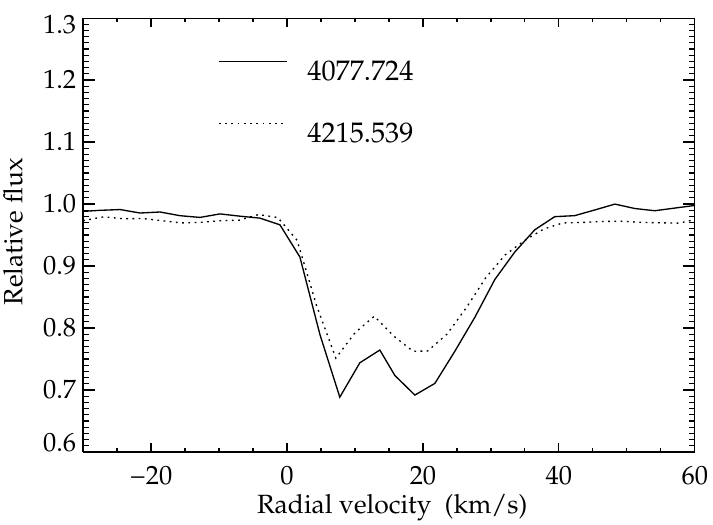
Fig. 5. Splitting of lines originating from low excitation levels in the spectrum of HD 52961. The lines of Sr II { λ = 4077.7 (cid:23)A (solid line) and 4215.5 (cid:23)A (dotted line) are plotted in the velocity scale. of the blue components is V r = 6 : 4 (cid:6) 0 : 9 km s − 1 . With the D-lines included, V r = 6 : 2 (cid:6) 1 : 6 km s − 1 . The mean velocity of the red components is V r = 19 : 5